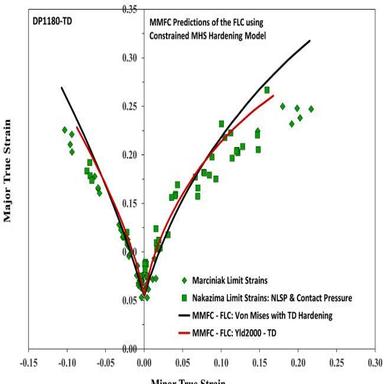
Comparison of the Marciniak and process-corrected Nakazima FLC data with MMFC-predicted FLCs in the transverse direction using von Mises and Yld2000 with the constrained MHS hardening model.